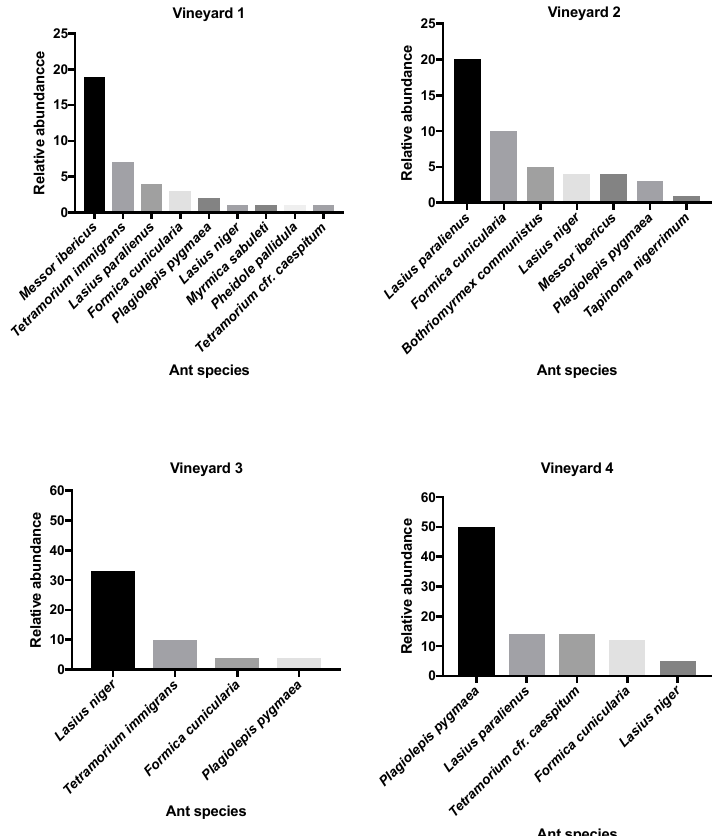
Figure 2. Relative abundance (%) of ant species collected in each vineyard. Relative abundance was calculated as the ratio between the number of each ant species and the total number of ants